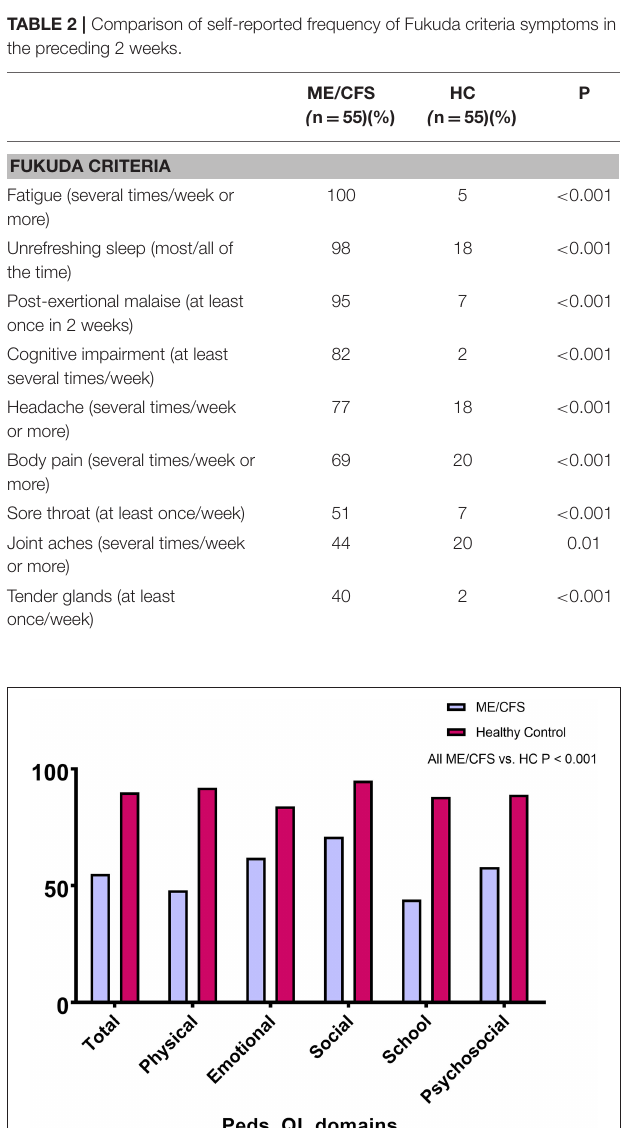
TABLE 3 | HRQOL comparisons for the FDI, MFS, and WMFI scales.